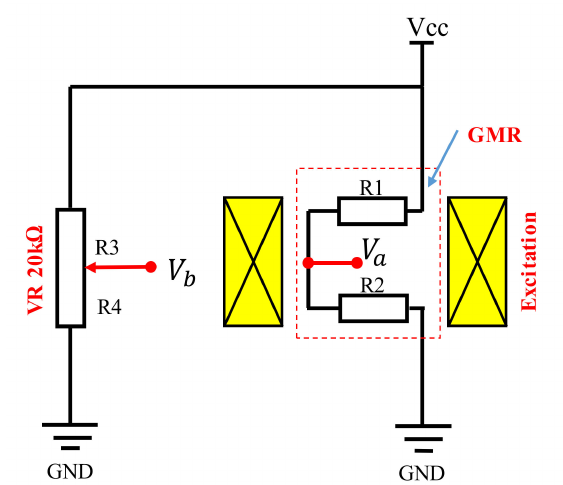
Figure 3. Circuit diagram of the developed probe consisting of the half-bridge GMR sensor chip and SMD VR 20 k Ω